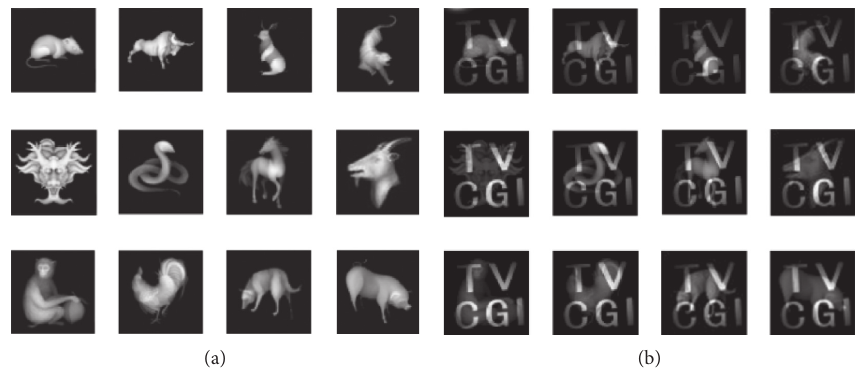
Figure 6: Experimental results of image fusion. (a) A group of “Zodiac” watermark patterns and (b) the corresponding imaging results.